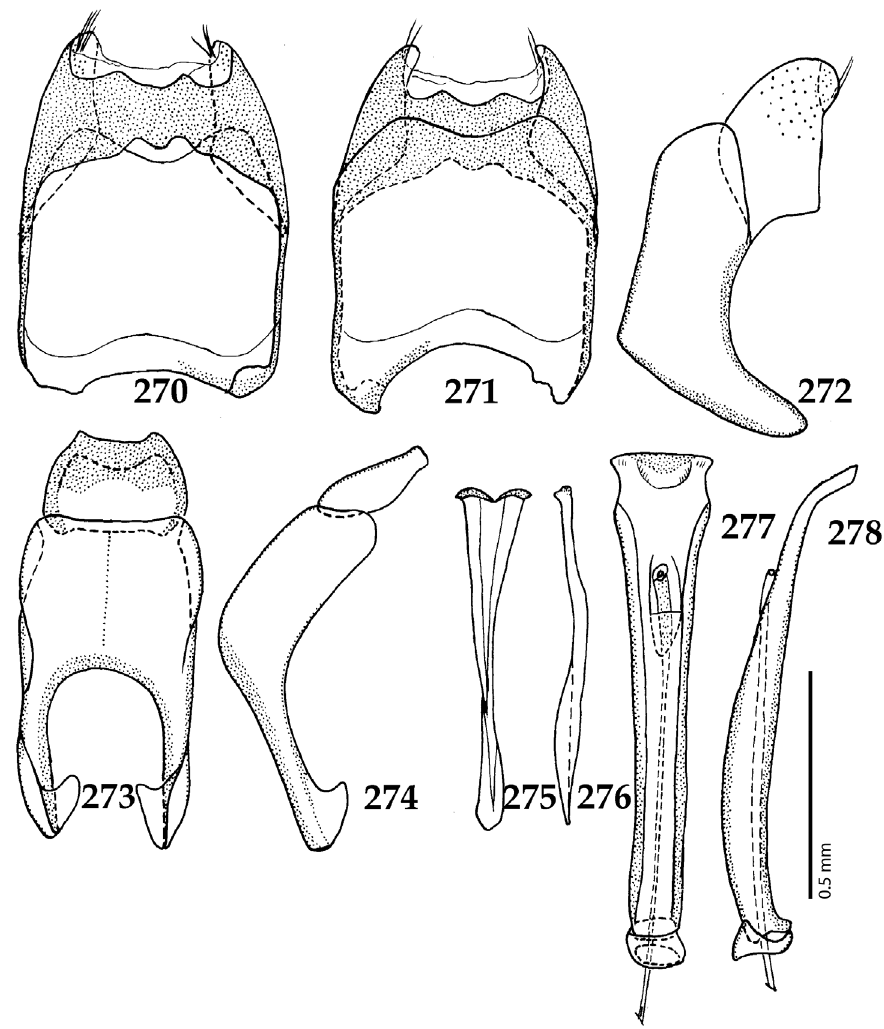
Figures 270–278. 270 Saprinodes distinctus Dégallier, 1993 male terminalia: 8 th sternite + 8 th tergite, ventral view 271 ditto, dorsal view 272 ditto, lateral view 273 male terminalia: 9 th + 10 th tergites, dorsal view 274 ditto, lateral view 275 male terminalia: spiculum gastrale, ventral view 276 ditto, lateral view 277 male terminalia: aedeagus, dorsal view 278 ditto, lateral